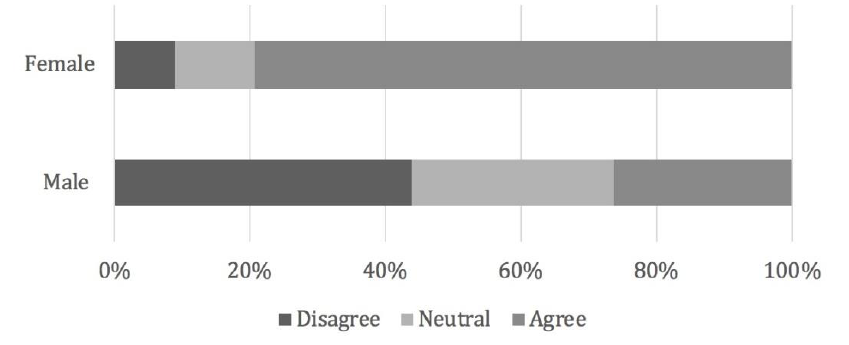
Fig. 4. Women have to work harder than men to succeed in engineering